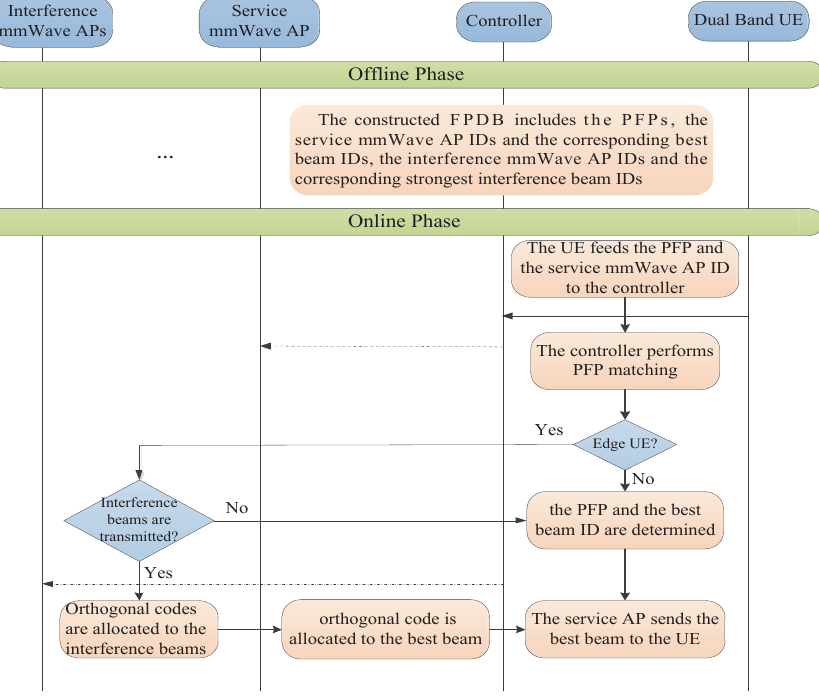
Figure 3. The proposed position fingerprint (PFP)-based multi-cell beam selection